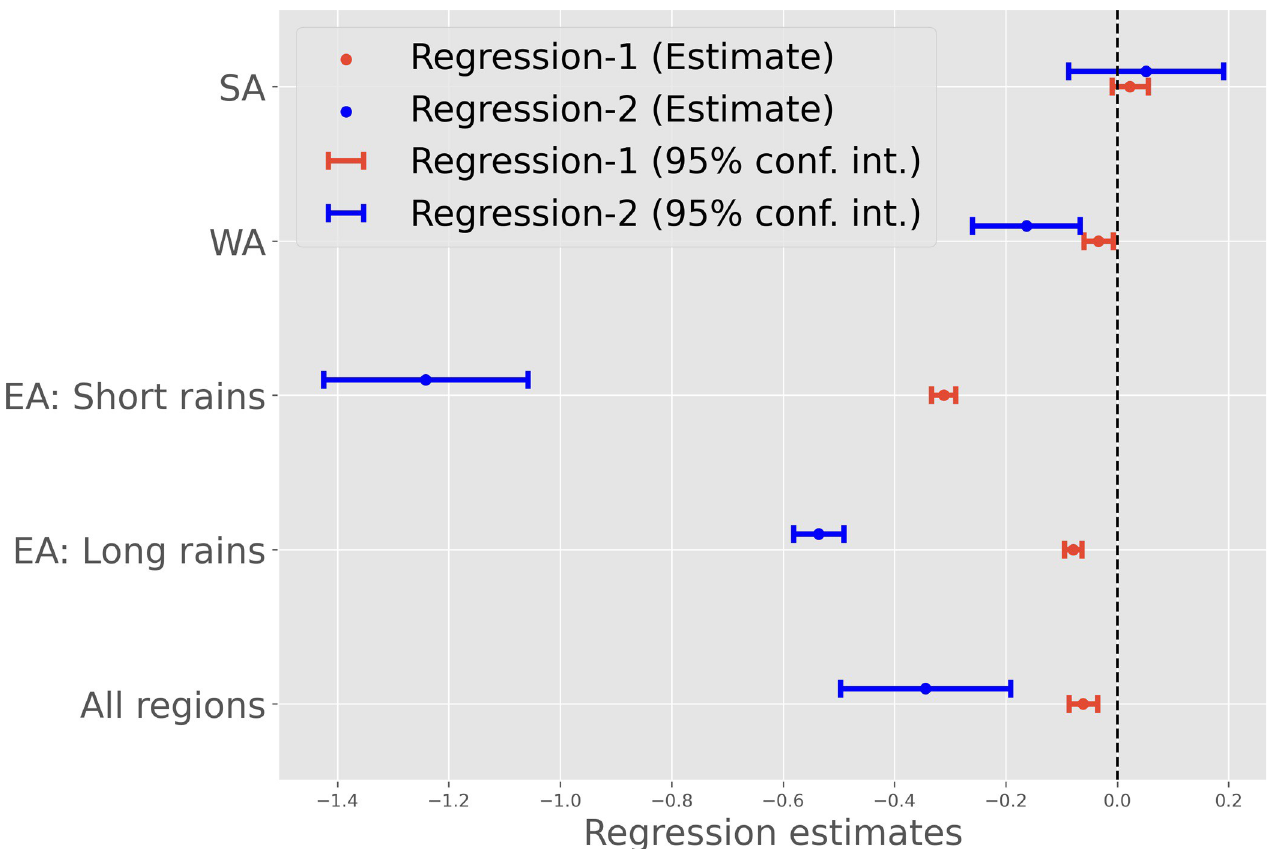
Fig 6. Regression estimates (and 95% confidence intervals) between standardized NDVI anomaly (NDVI Z ) and (a) absolute onset date anomaly (“Regression- 1”- see eq. [1]) and (b) discreet onset date anomaly (“Regression-2”- see eq. [2]), where onset anomaly is treated as a binary variable of value 0 (on time or early onset) or 1 (more than 2 dekad delay in onset date). We use two-way clustering to adjust confidence for both serial and spatial correlation; see section 2.4 for more details.